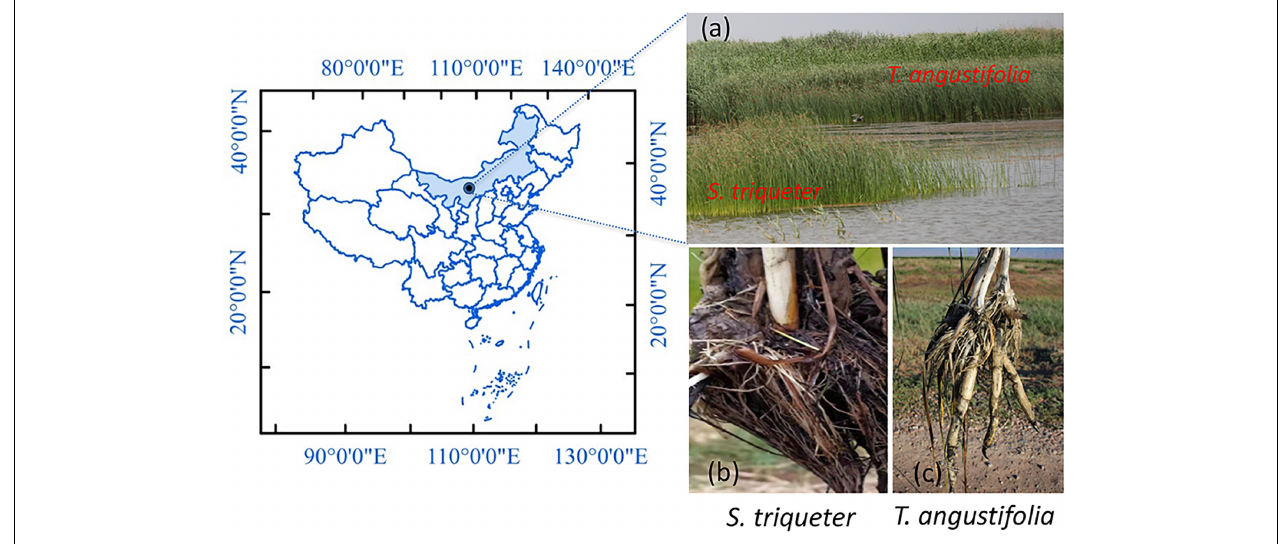
FIGURE 1 | Sampling site (a) of Scirpus triqueter (b) and Typhus angustifolia (c) in the natural wetland of Wuliangsuhai.